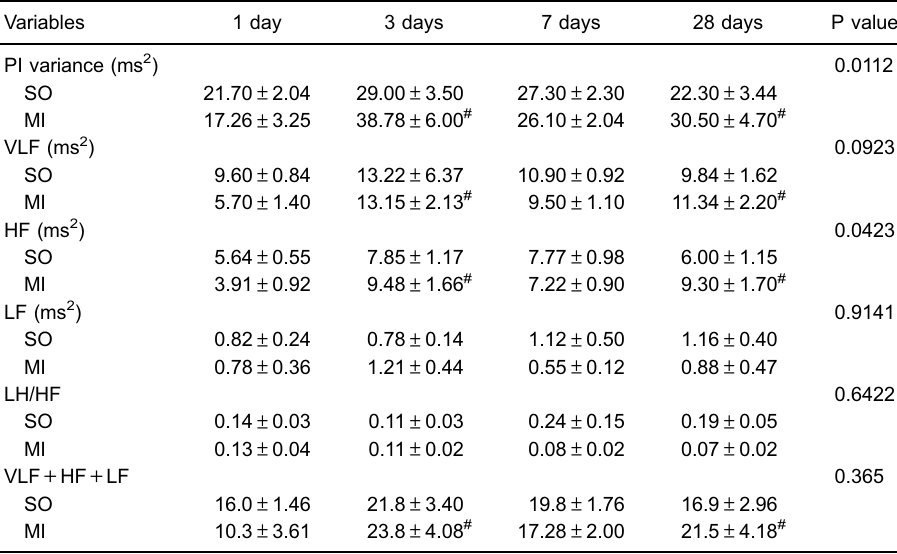
Table 2. Parameters of time and spectral heart rate variability in sham-operated (SO) and infarcted (MI) rats studied at different times after surgery.